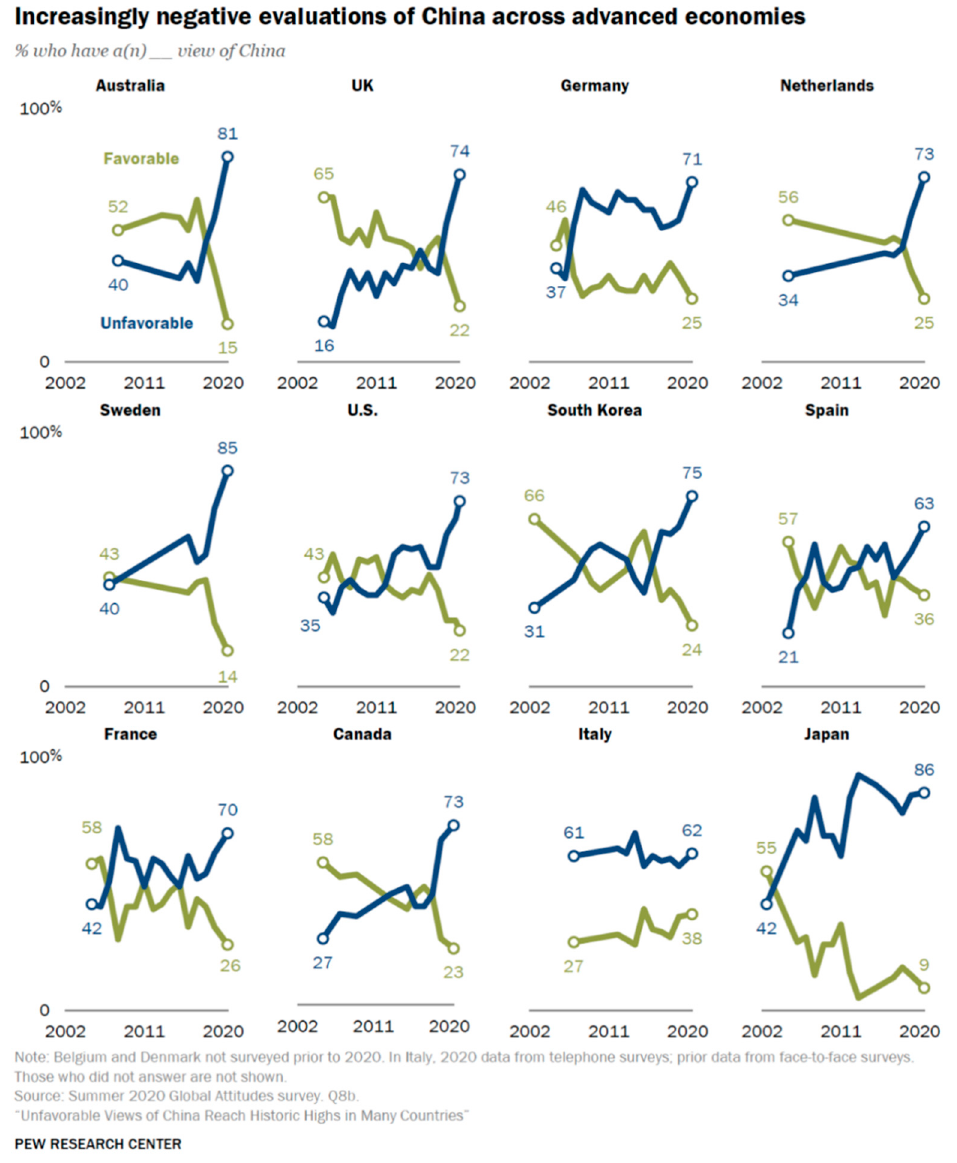
Figure 4. Increasingly negative evaluations of China across advanced economies. Source: Pew Research Center.